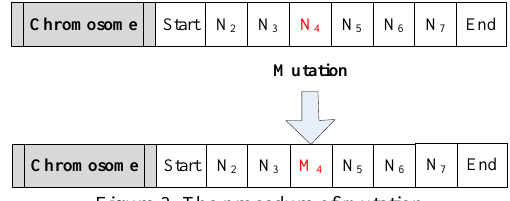
Figure 3. The procedure of mutation